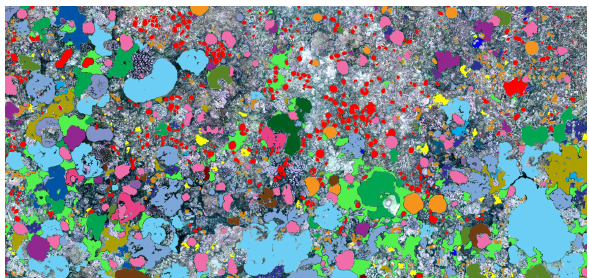
Figure 1. Coral class distribution. Courtesy of Scripps Institution of